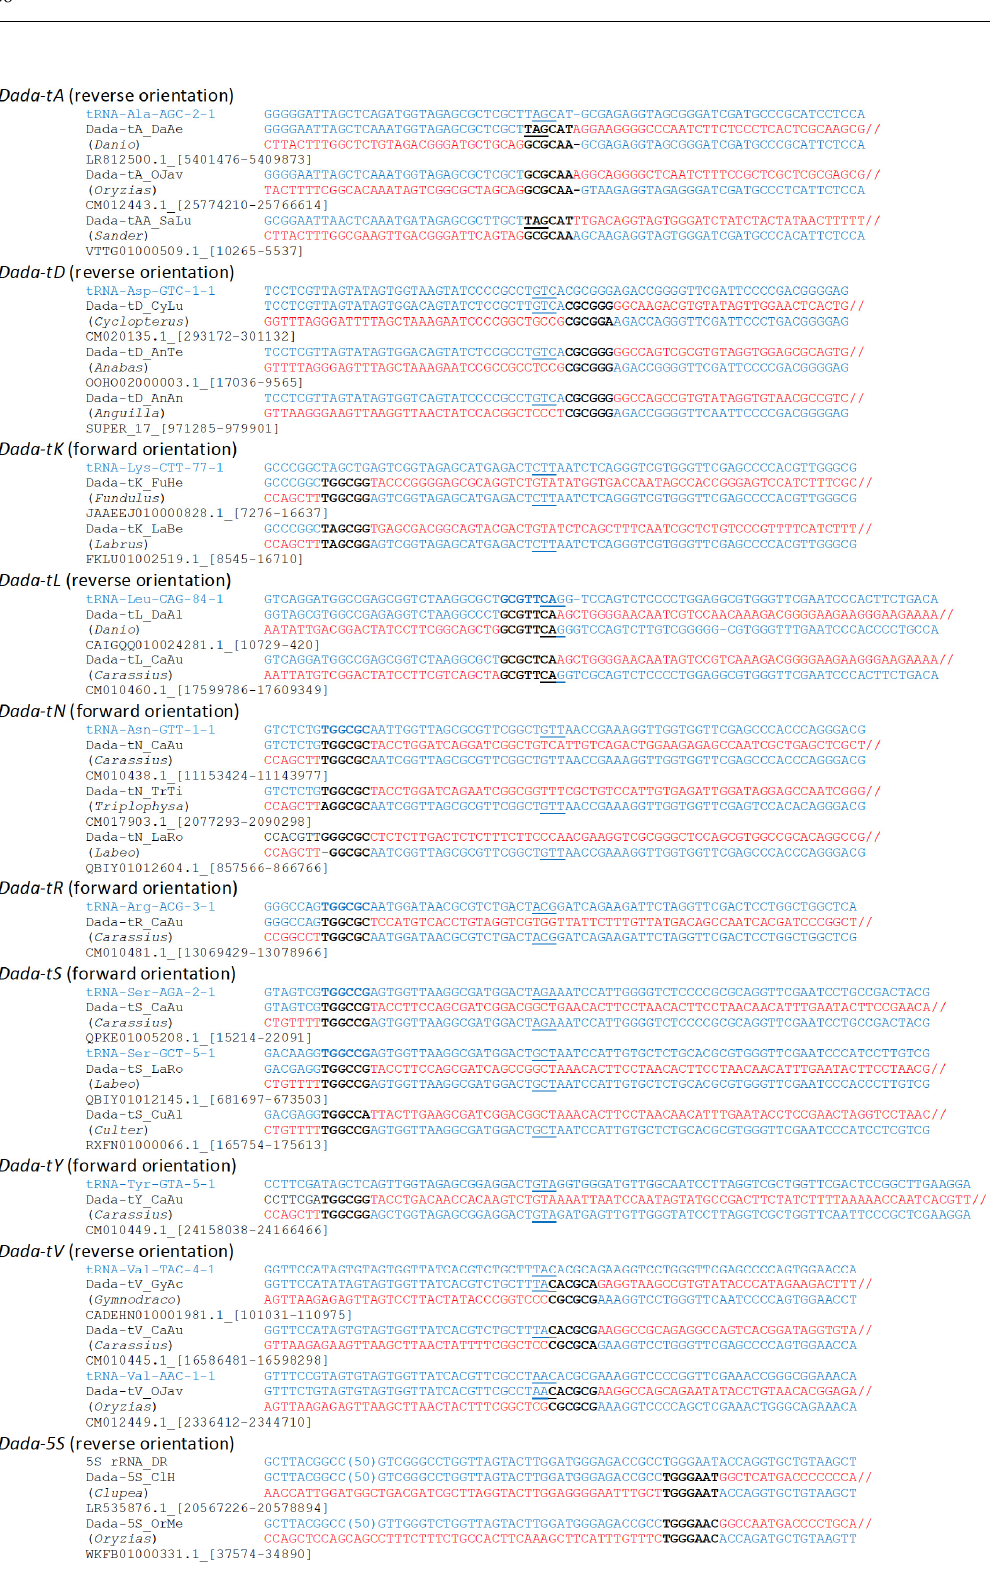
Figure 1. Target sequences of Dada families. Several representative insertions are shown with zebrafish tRNA genes. tRNA genes are based on GtRNA-DB (http://gtrnadb.ucsc.edu/ (accessed on 7 July 2021)). Genus names of the host organisms are shown in parentheses below the Dada family names. Accession numbers and locations are shown below the genus names. tRNA gene sequences are in blue, while Dada sequences are in red. TSDs are in bold. Anticodons are underlined.